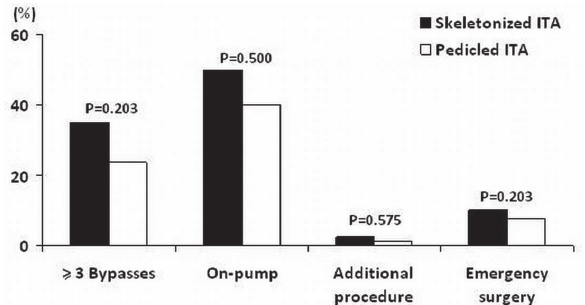
Fig. 3 – Description of surgical procedures characteristics in elderly undergoing CABG. ITA =- internal thoracic artery; CABG =